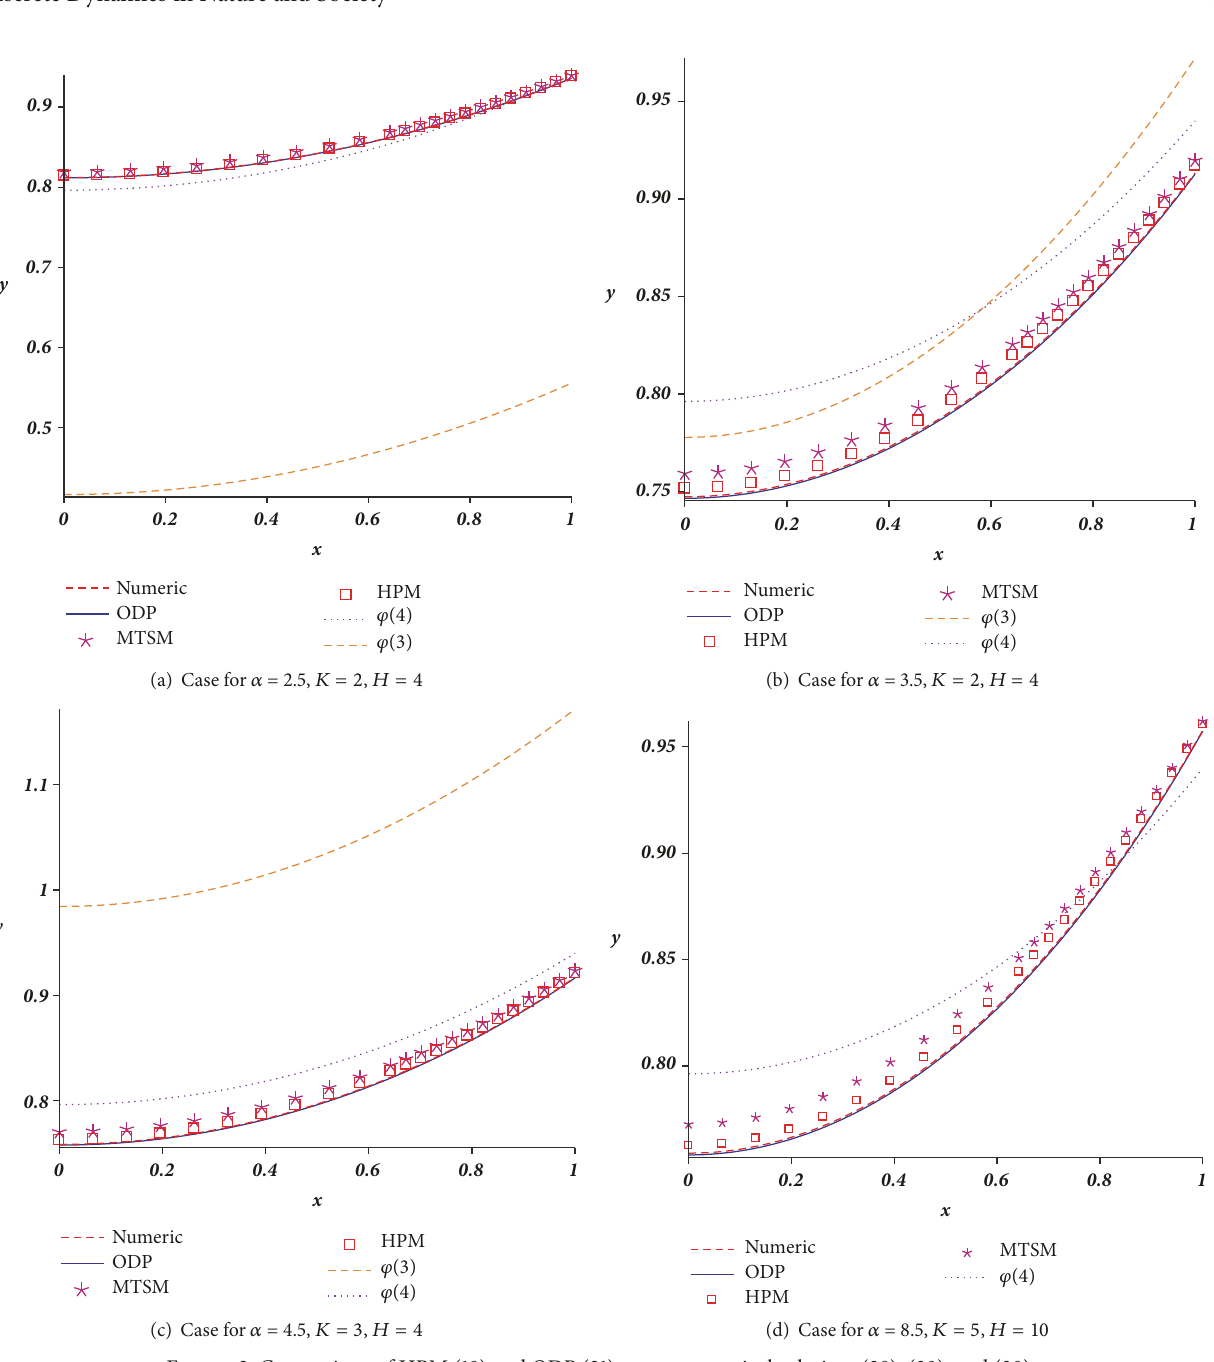
Figure 2: Comparison of HPM (19) and ODP (21) versus numerical solution, (28), (29), and